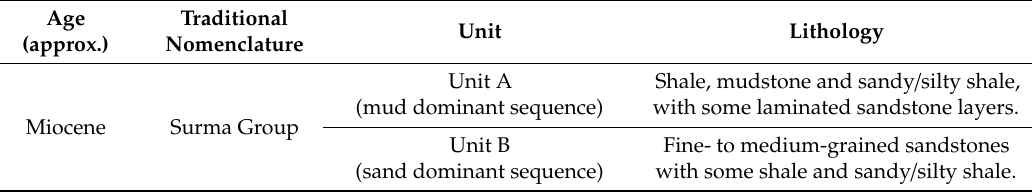
Table 1. Reservoir succession of Shahbazpur#2